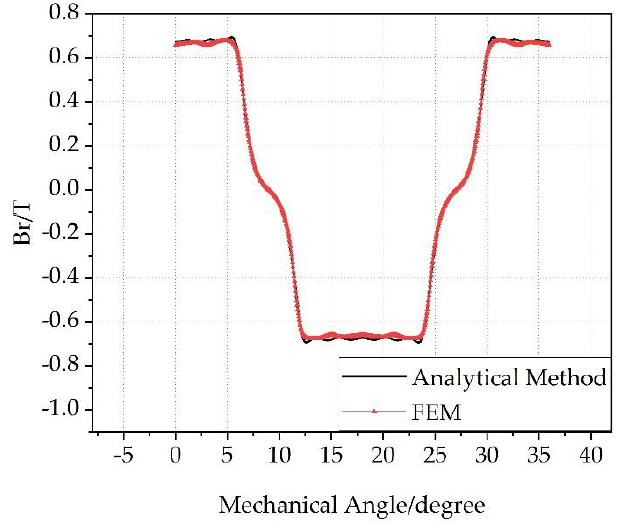
Figure 8. Comparison of the radial component of magnetic field.